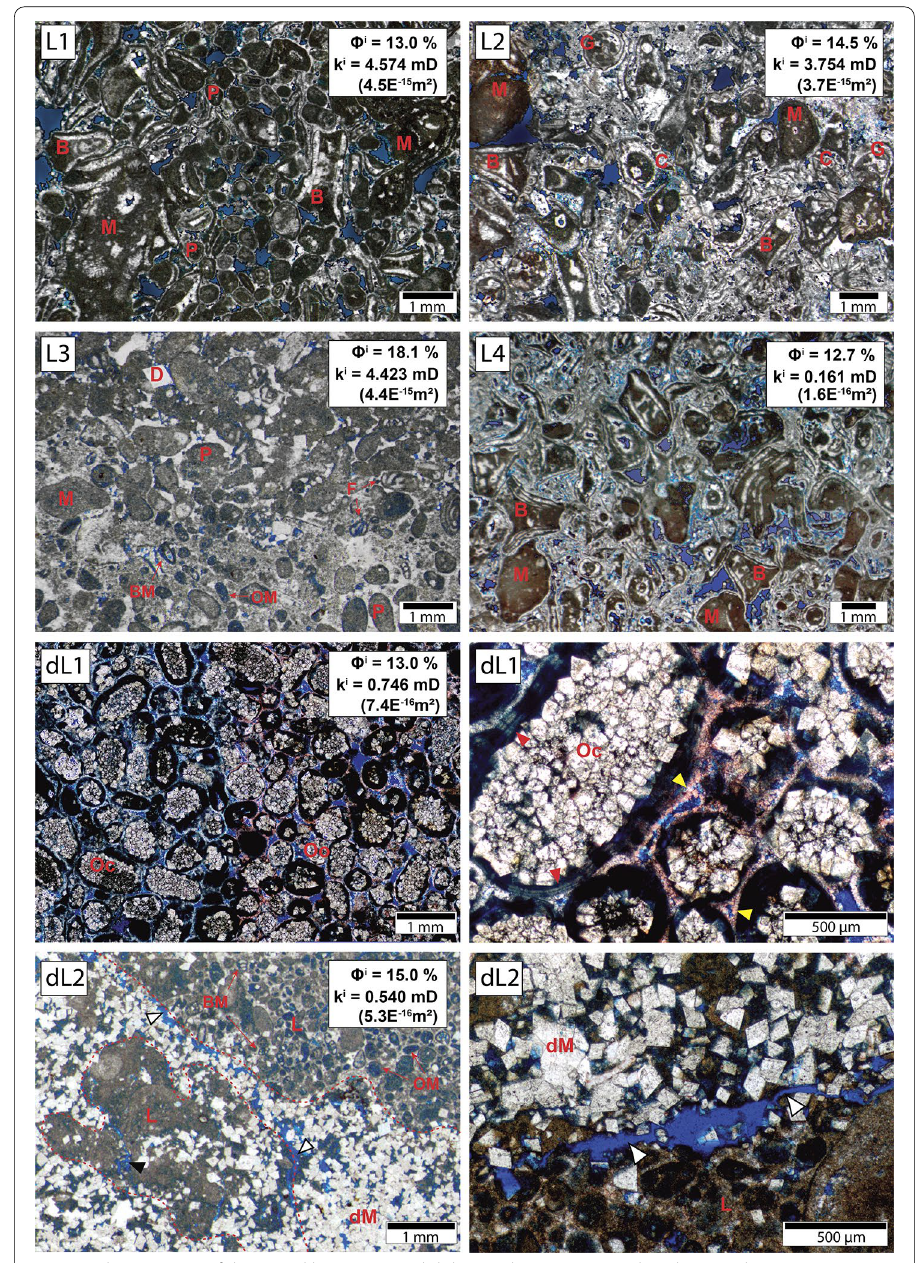
Fig. 16 Thin sections of the tested limestone and dolomitic limestone samples. The samples were impregnated by blue-dye resin to visualize the pore space and partially stained by Alizarin-S for identification of calcite minerals. See text for detailed description of the thin sections and the classification of